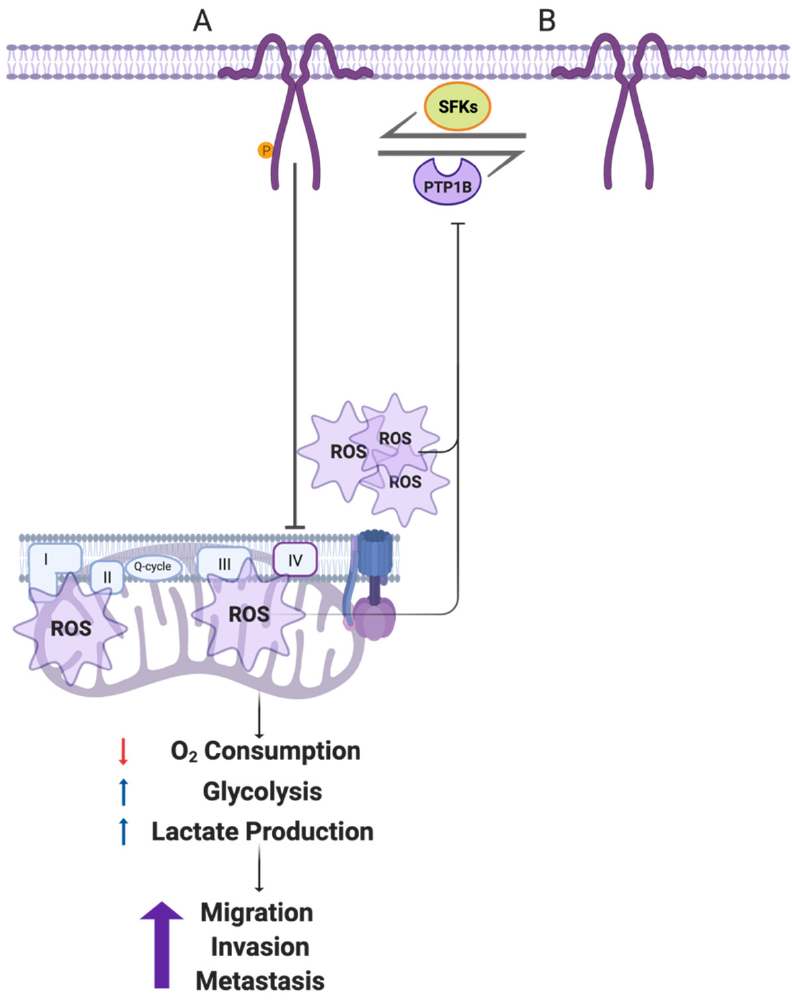
Figure 8. Working model summarizing the main findings described in this study. ( A ) In metastatic cells, CAV1 is phosphorylated on Y14 by Src family kinases. pY14-CAV1 inhibits the mitochondrial IV complex or impairs the ability of the cell to recover from complex III damage, increasing the ROS production (shown as emanating from complex III, as well as complex I/II) and accumulation both in mitochondria and cytosol. Mitochondrial inhibition decreases the oxygen consumption and promotes a metabolic Warburg-like switch to an aerobic glycolytic phenotype. These events enhance cell migration, invasion, and metastasis driven by CAV1 expression. In addition, CAV1 expression and phosphorylation on Y14 inhibits the activity of the phosphatase PTP1B ( B ) by augmenting ROS. In this way, the metabolic switch and ROS formation generate a feed-backward amplification loop to promote CAV1 phosphorylation on Y14 and thereby the increase in cell migration, invasion, and metastasis. Created with BioRender.com (Accessed on 5 May